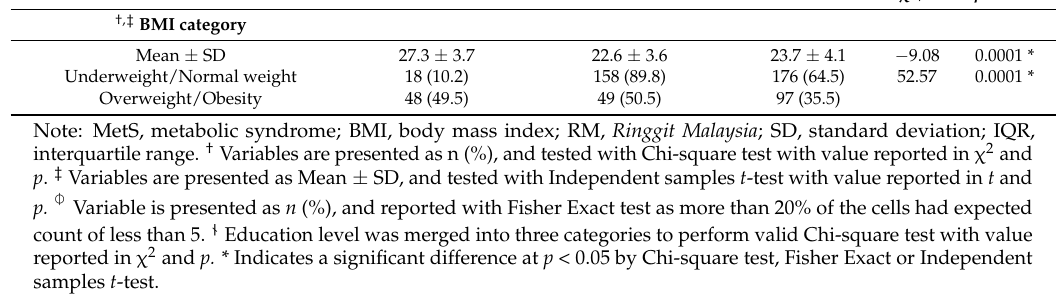
Table 4. Logistic regression analysis of MetS risk factors among